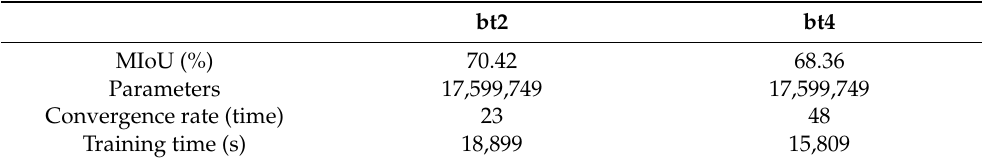
Table 5. Model training results under different batch size conditions.